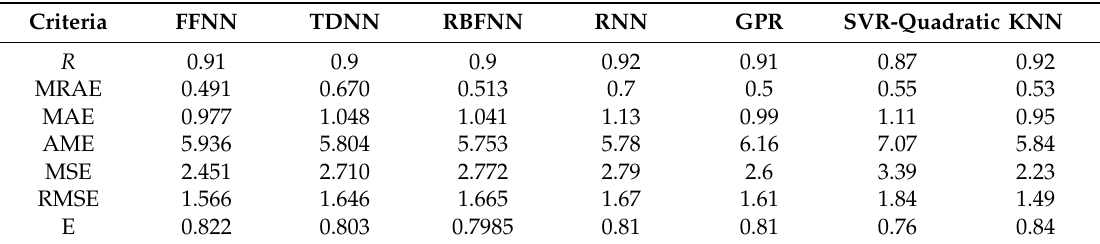
Table 3. Residual criteria for the results of verification data, Alavian